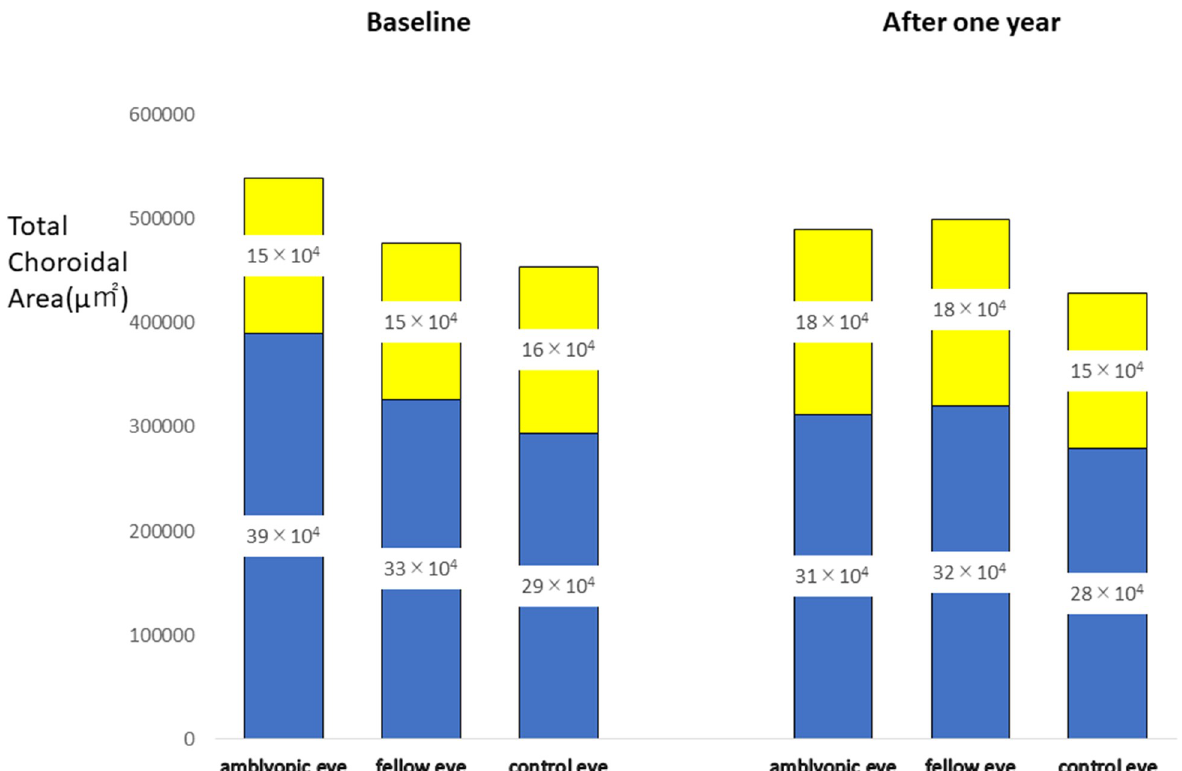
Fig 1. Changes of the choroidal area after one year of optical correction. After one year of the optical correction, the luminal choroidal area in the amblyopic eye was significantly narrowed and the stromal area was significantly widened. In the fellow eyes, the stromal area was significantly widened after the optical correction. There were no significant changes in the control eyes. Blue Area: Luminal Area, Yellow Area: Stromal